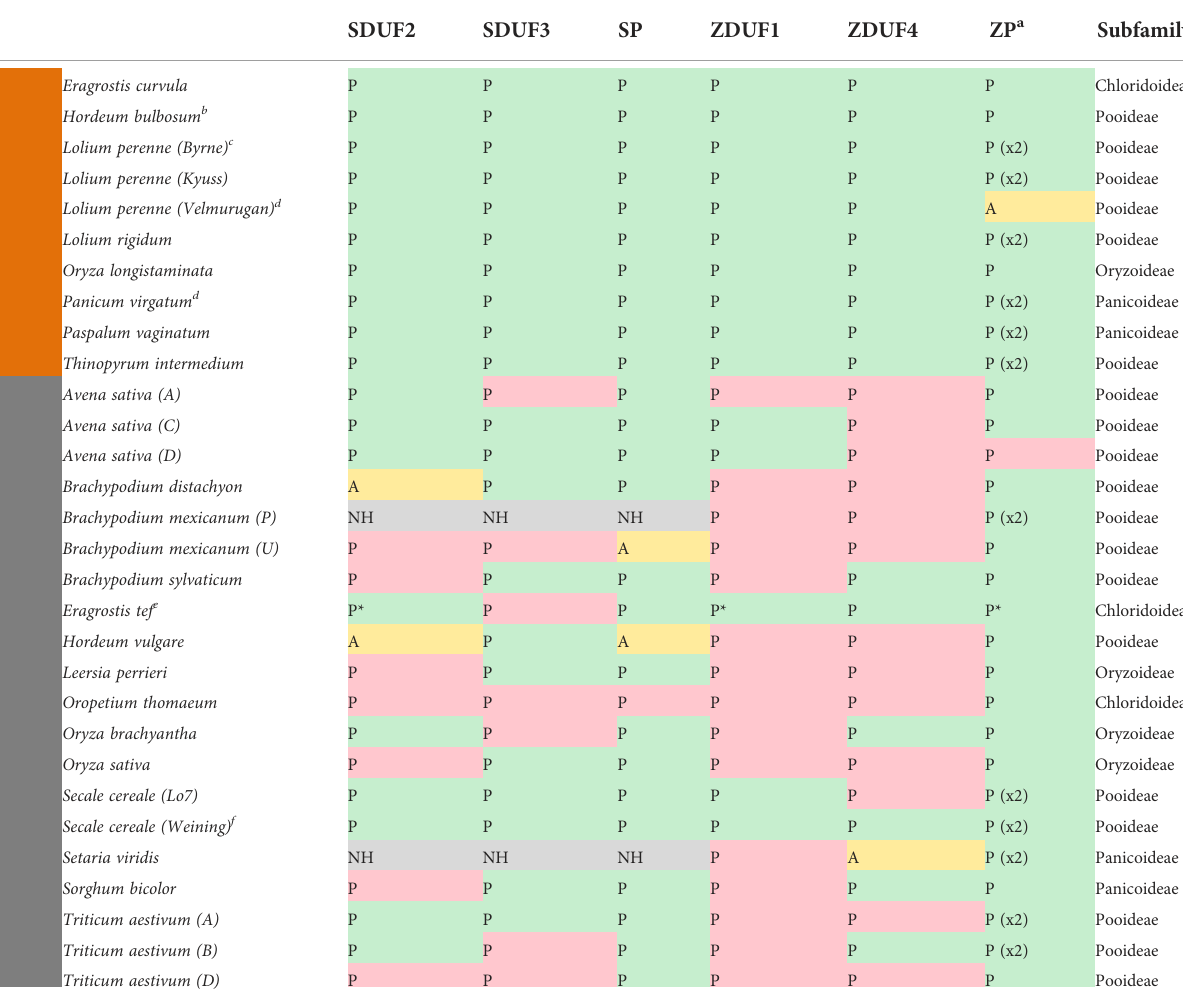
TABLE 1 Presence of SI determinants in other grass